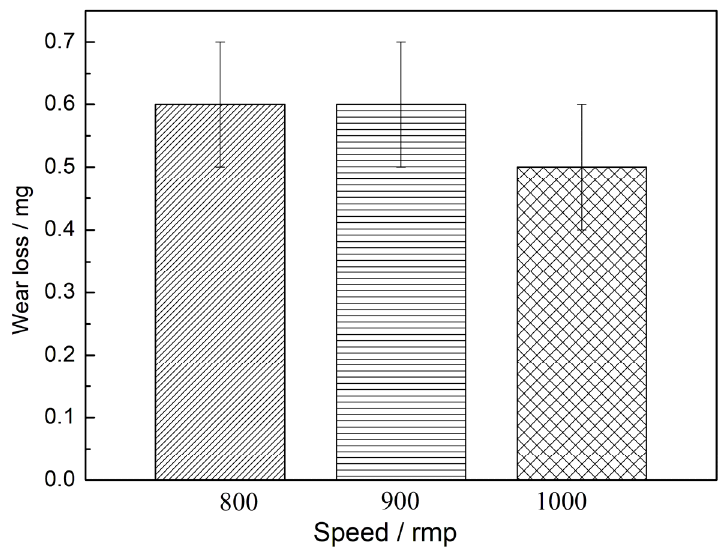
Figure 11. Wear loss at different speeds.